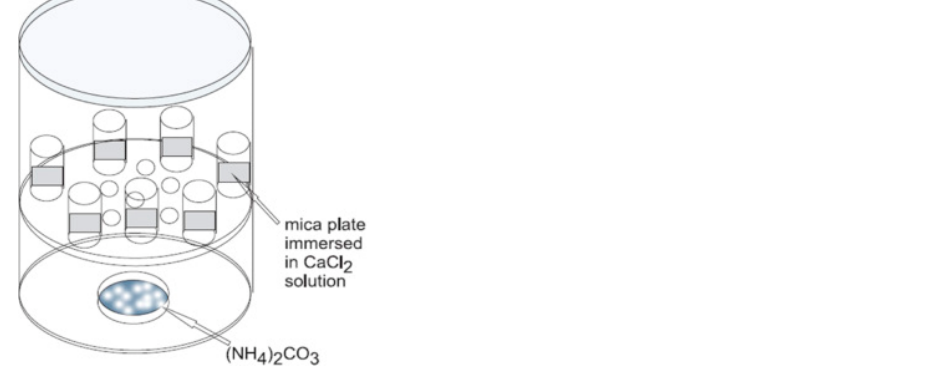
Figure 19. Schematic representation of experimental system for calcium carbonate mineralization. The figure is adapted with permission from [29].